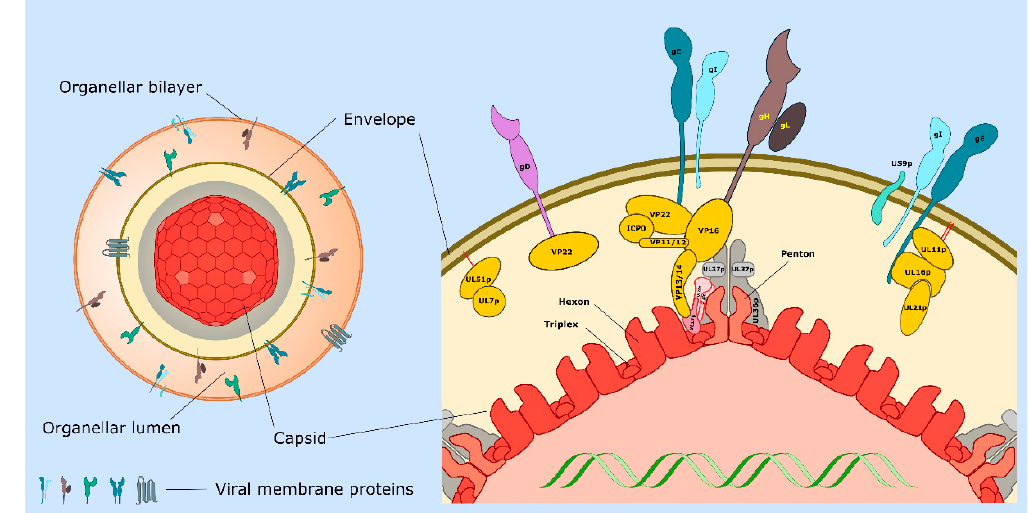
Figure 1. Structure of the cytoplasmic herpes simplex virus type 1 (HSV-1) particle during egress. Left: The organelle-associated enveloped virion (OEV). The icosahedral capsid (with red hexons and pale red pentons) is bound to inner tegument proteins including UL36p and UL37p (gray layer), which provide the foundation for attachment of outer tegument (yellow). Tegument connects the capsid to the surrounding envelope (dark brown line) containing numerous single and multiple membrane-spanning envelope proteins. The mature virion resides within the lumen (orange) of the organelle utilized for envelopment. Prior to capsid envelopment the lipid bilayer of the bounding organelle must contain all of the membrane proteins that become incorporated into the mature envelope. This figure assumes that these envelope proteins persist in the bounding membrane of the OEV, though in most cases this is unknown. Right: Expanded view of a region of the capsid shell (red), inner- (gray), and outer- (yellow) tegument proteins and the envelope (dark brown bilayer). VP5 hexons and pentons are colored as in left-hand particle, and hexons, pentons, and triplexes are indicated. At the penton vertices each copy of VP5 is connected to a UL36p dimer and to adjacent triplexes via a UL17p/(UL25p) 2 complex (for clarity the figure shows only two copies of VP5 at the vertex, and one copy of UL17p/(UL25p) 2 ). Envelope proteins gD, gE/gI, gH/gL, and US9p (Table 1) are shown imbedded in the envelope bilayer such that their cytoplasmic tails project inward to connect with tegument proteins. Red lines indicate lipid anchors stabilizing the interaction of UL11p and UL51p with the envelope. Some proteins (for example gE and VP22) participate in multiple interactions within the tegument. These are drawn as separate complexes for clarity, but we do not mean to imply that these associations are necessarily exclusive of one another. See Table 1 and text for more details.